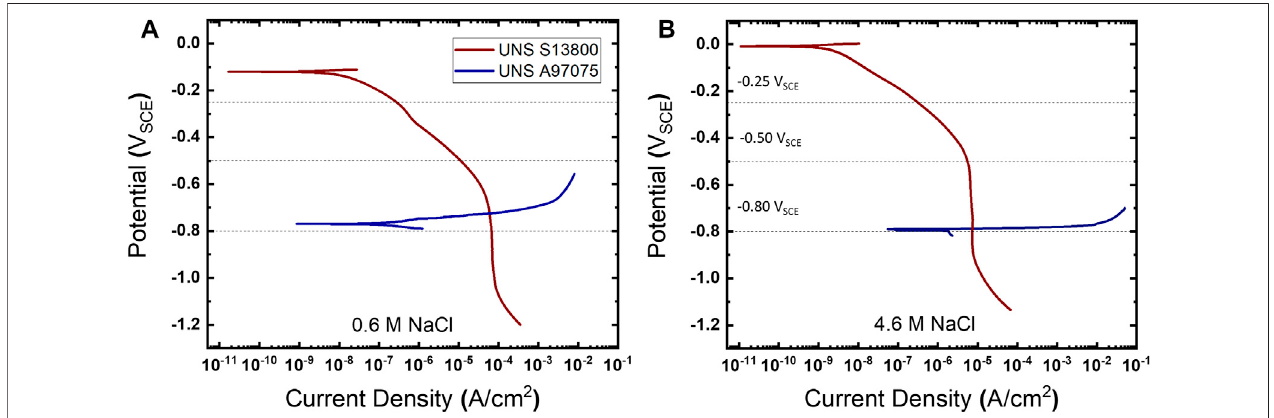
FIGURE 2 | The polarization curves for UNS S13800 and UNS A97075 in (A) 0.6 and (B) 4.6 M NaCl at 25 °